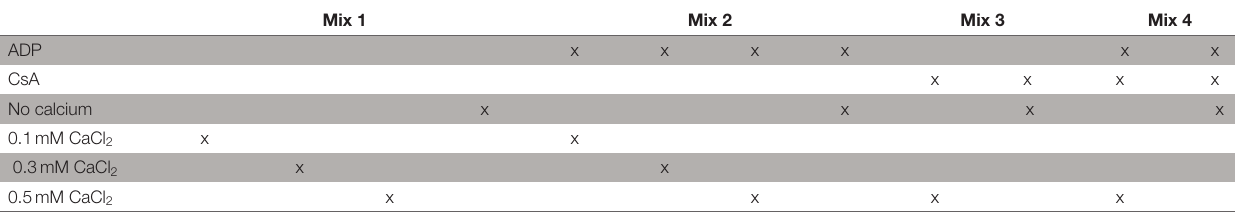
TABLE 2 | Additions to the various solutions used for the calcium retention capacity assay.